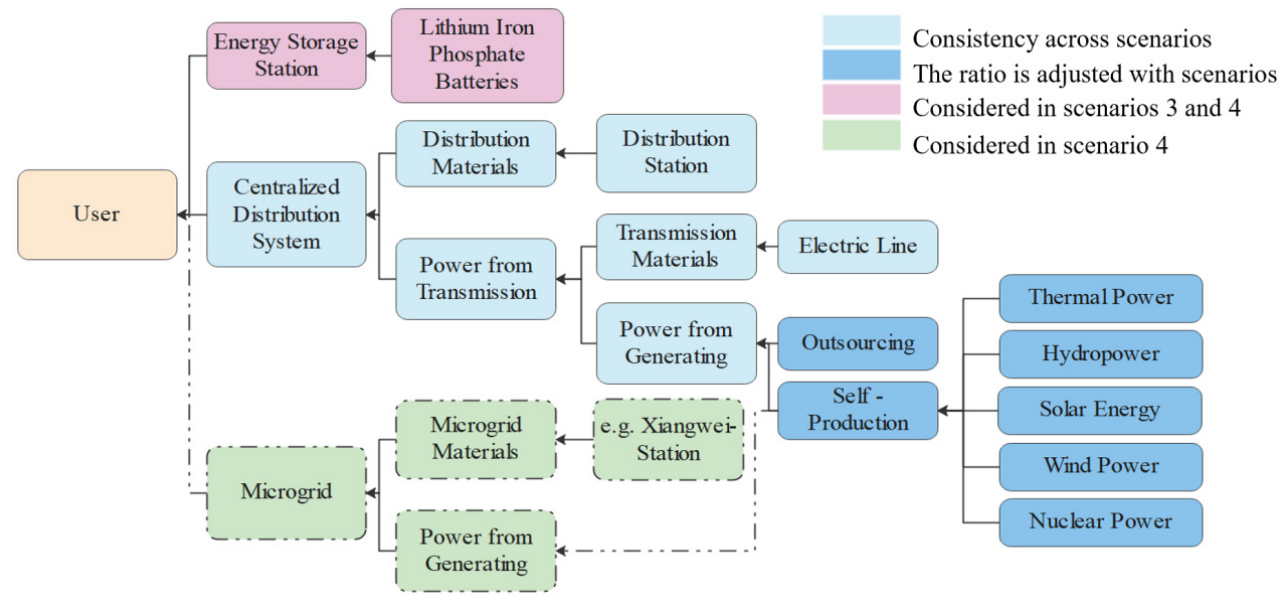
Figure 4. Scenario design in this study.